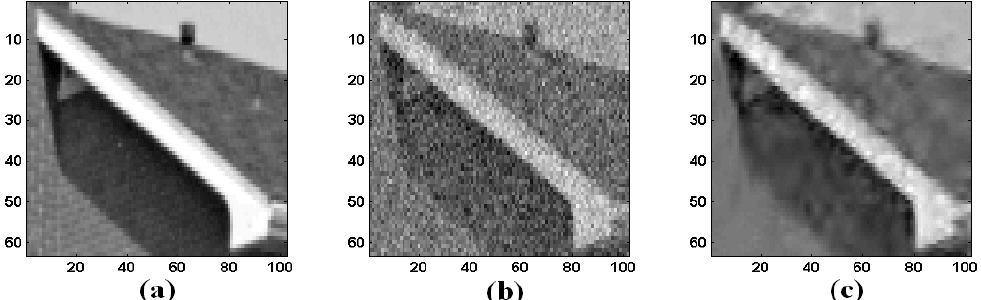
Figure 1. ( a ) An edge of House Image, ( b ) Image with Gaussian white noise (Input PSNR = 18.59 dB), ( c ) After Denoising (PSNR = 28.77